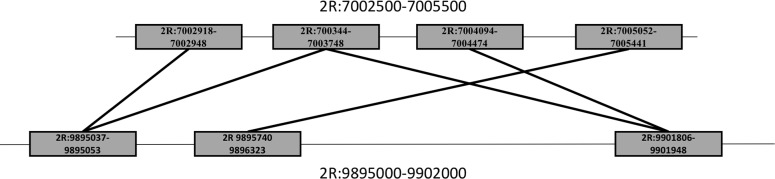
Many rearrangements lie in the same region making it hard to fully elucidate the nature of a particular rearrangement.For instance, in line CY21B3 has 5 rearrangement calls (represented by the connecting lines of the two large sections of chromosome 2R) associated with two regions 2R:7002500–7005500 and 2R:9895000–9902000. 4 separate small regions that are separated by at least 1 sequencing insert size (325 bp) within 2R:7002500–7005500 have reads that pair with 3 separate small regions between 2R:9895000–990200. All the lines always show at least one of these rearrangements but generally each line has 2–3 separate rearrangement calls between regions 2R:7002500–7005500 and 2R:9895000–9902000. The 9.9Mb breakpoint lies close to the known inversion breakpoint on 2R where recombination is suppressed.